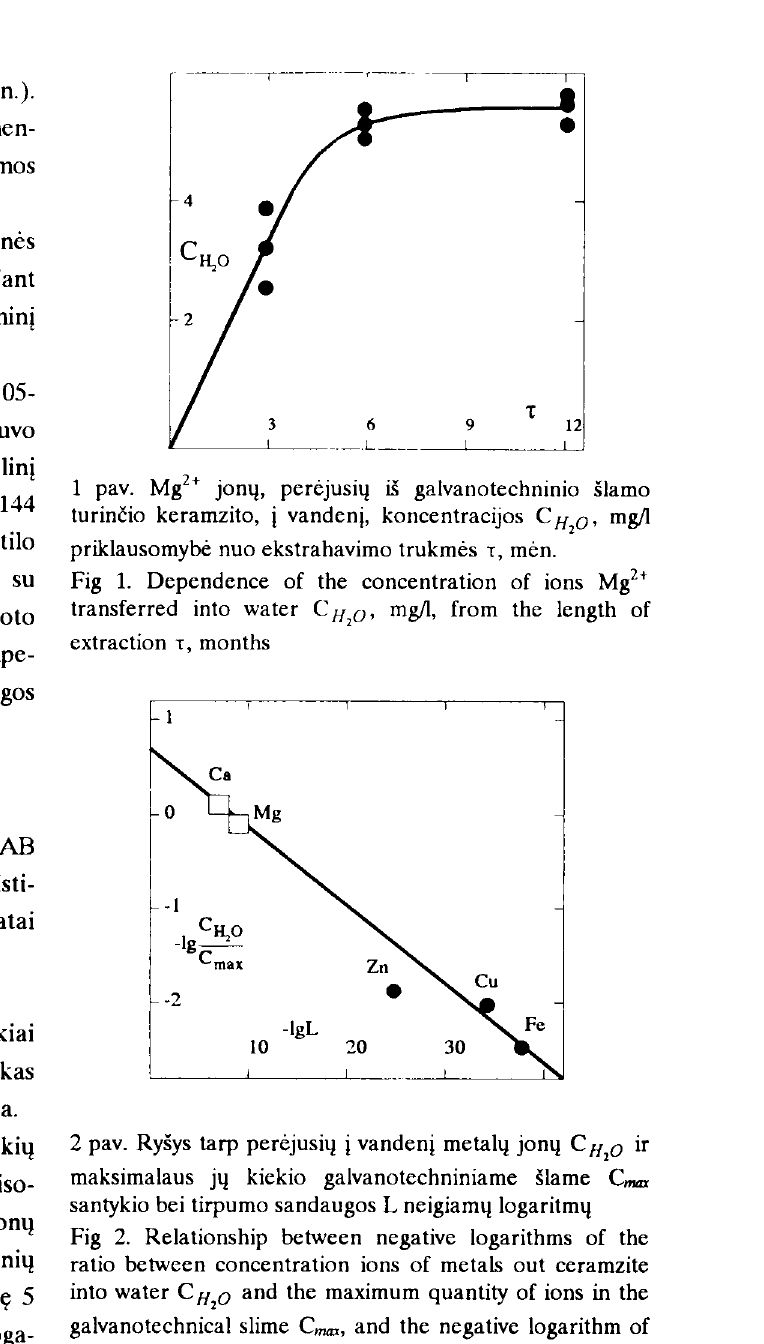
Fig 2. Relationship between negative logarithms of the ratio between concentration ions of metals out ceramzite into water CH o and the maximum quantity of ions in the 2 galvanotechnical slime Cmax, and the negative logarithm of solubility